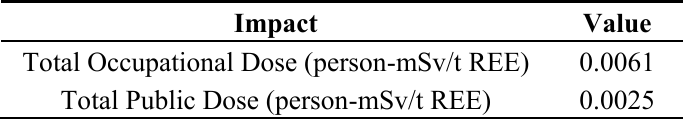
Table 5. Summary of radiological impacts of REE